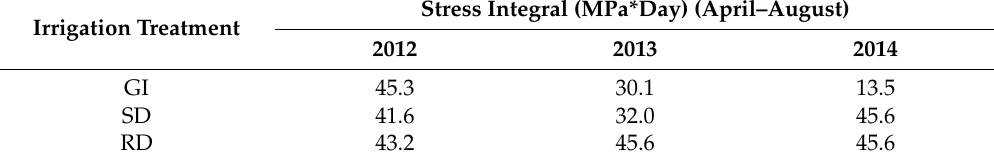
Table 3. Stress integral in megapascal a day (MPa * Day) for grower irrigation (GI), sustained deficit (SD) and regulated deficit (RD) irrigation treatments in Fiesta raisin grape deficit irrigation study for the period from April to August at the Caruthers, CA. field